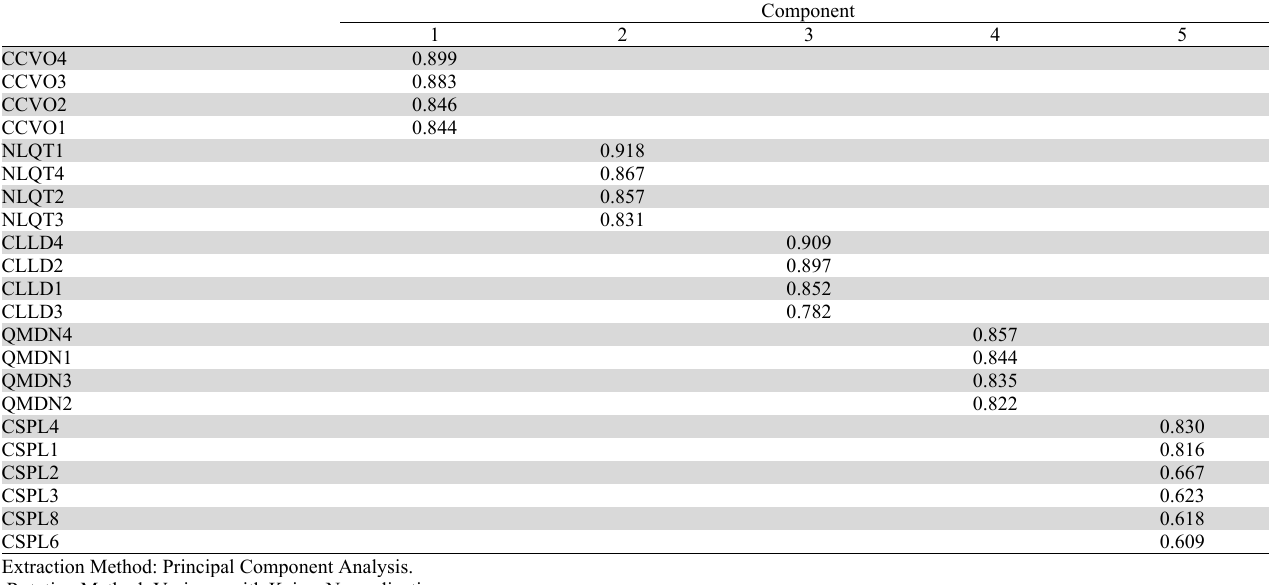
Extraction Method: Principal Component